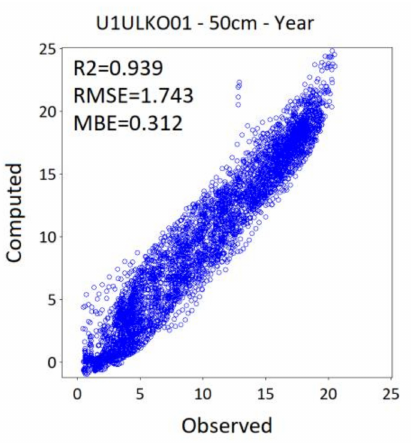
Figure A16. Validation at site U1ULKO01 for 50 cm soil depth.